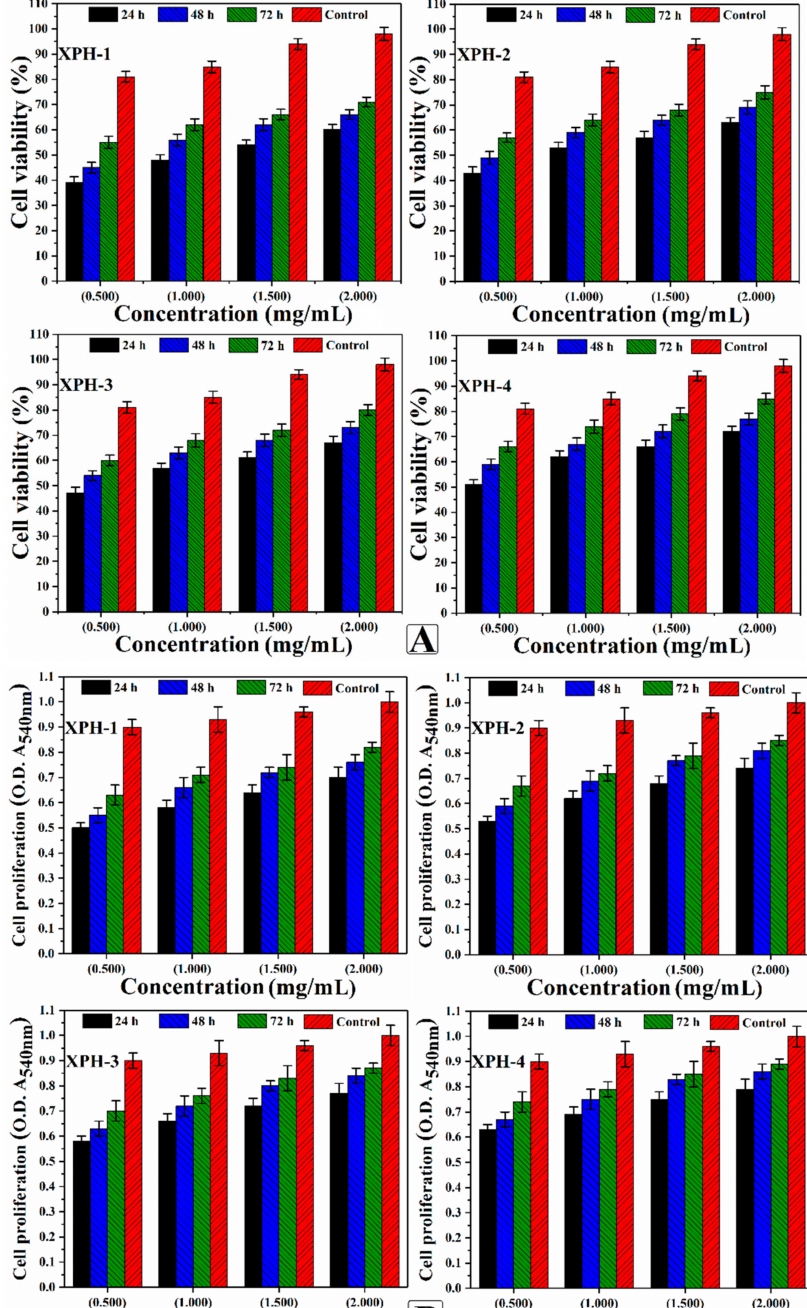
Figure 7. Presents the cellular behavior of MC3T3-E1 against different concentrations (0.500, 1.000, 1.500, and 2.000 mg/mL) of polymeric hybrid nanocomposite scaffolds at different time intervals (24, 48, and 72 h) to ( A ) determine cell viability and ( B ) optical density under standard in vitro